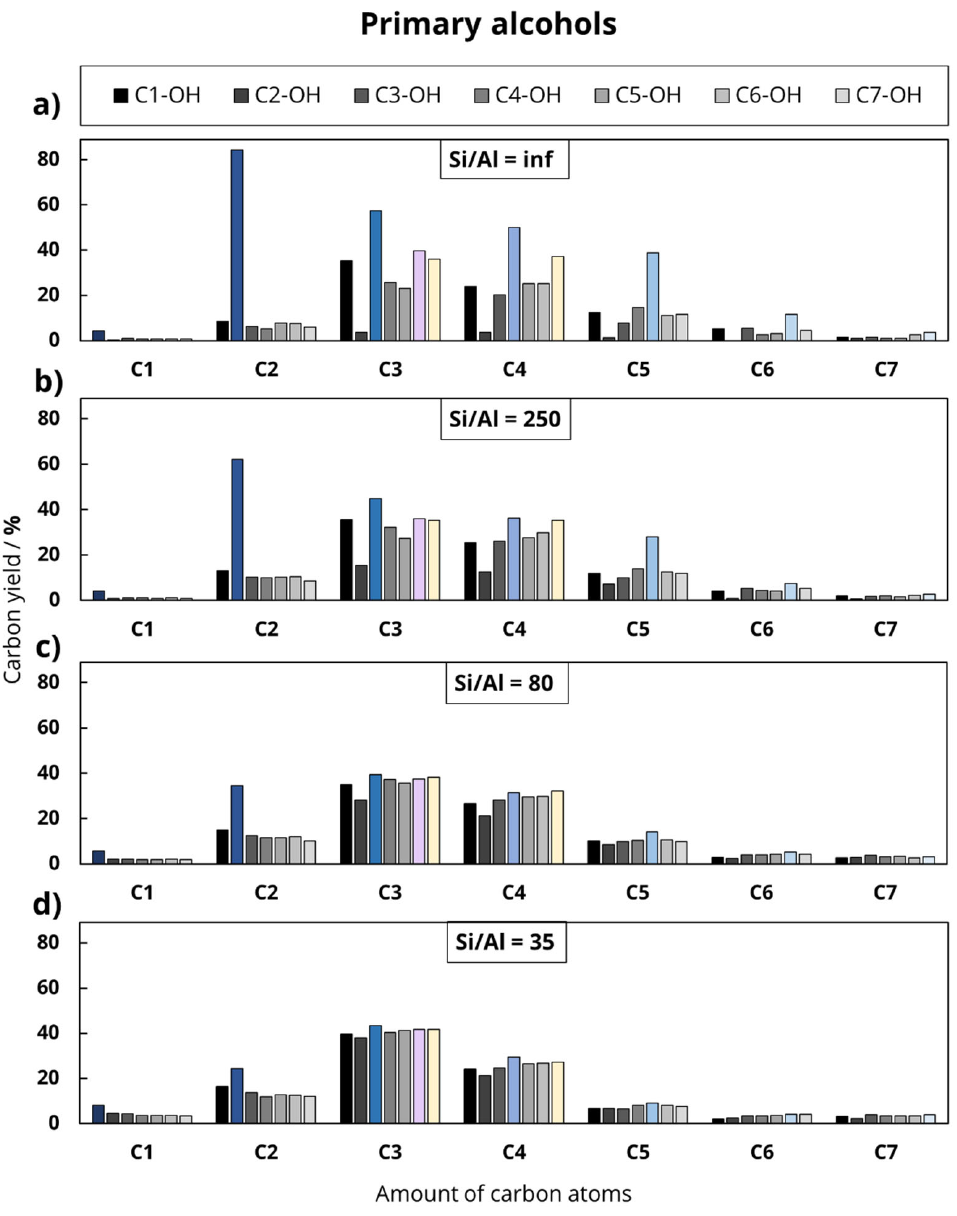
Figure 5. Comparison of catalytic results of prepared H ‐ ZSM ‐ 5 zeolite samples with various Si/Al ratios ( a – d ) in the conversion of primary alcohols C1 ‐ OH to C7 ‐ OH; blue bars = increased carbon yield for products corresponding to direct dehydration of primary alcohols (increased C2 for C2 ‐ OH, increased C3 for C3 ‐ OH, etc.); pink bars = increased carbon yield for direct cleavage of C6 product after dehydration of C6 ‐ OH into C3 + C3; yellow bars = increased carbon yield for direct cleavage of C7 product into C3 + C4 after dehydration of C7 ‐ OH.